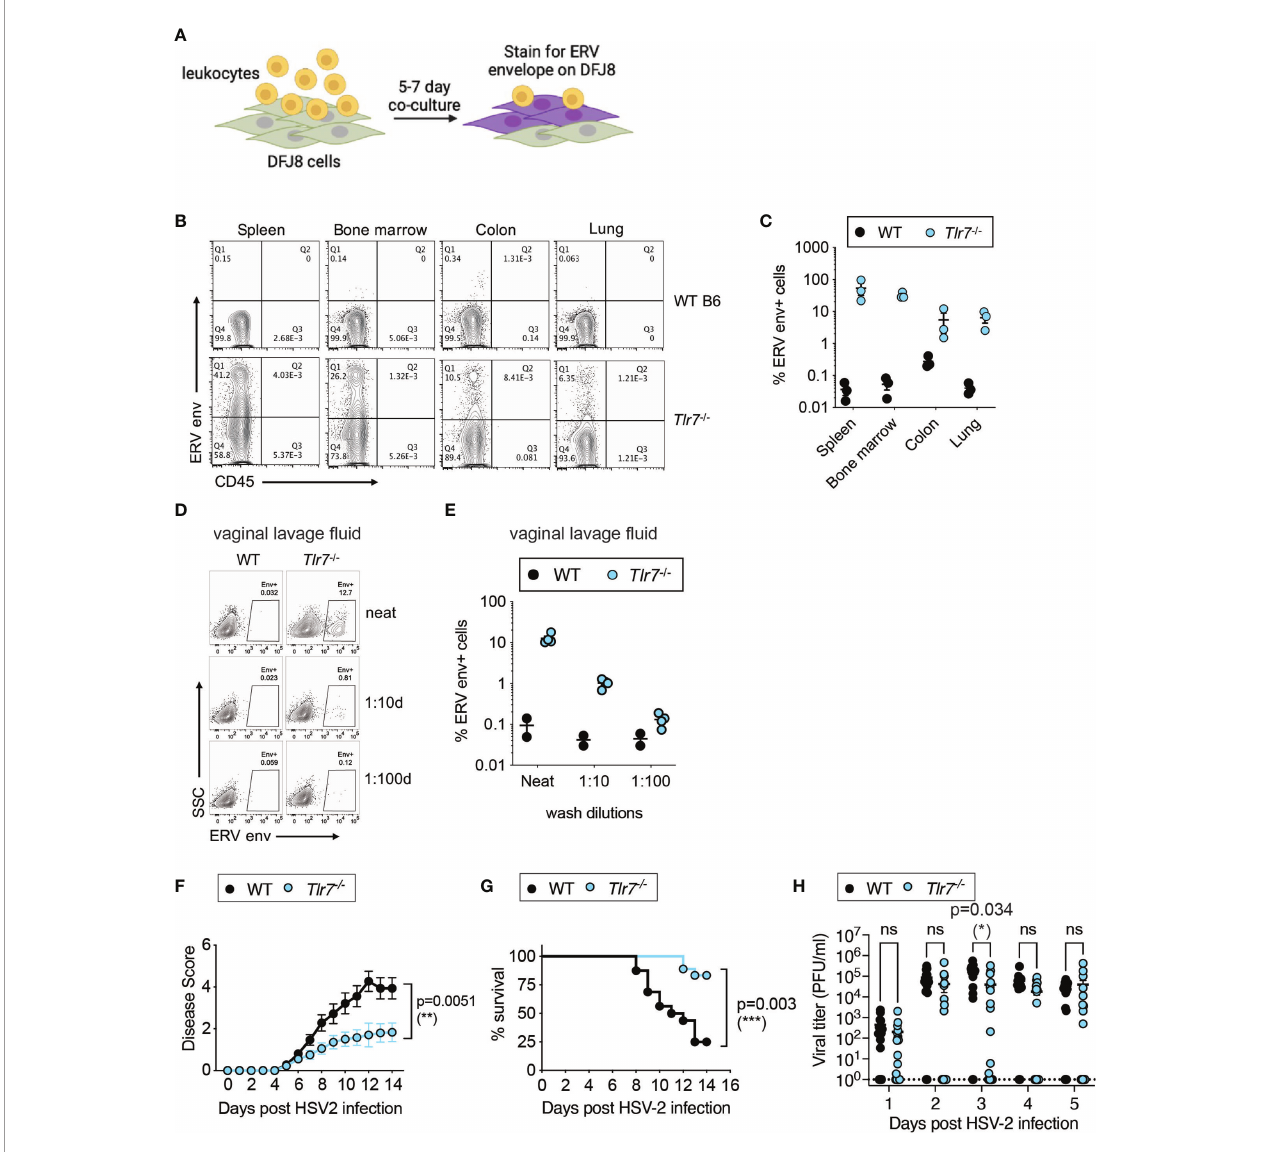
FIGURE 1 | Elevated infectious ERVs and HSV-2 resistance in Tlr7 -/- mice. (A) Schematic of DFJ8 co-culture assay to measure infectious ERVs. (B, C) Representative FACS plots of DFJ8 cells co-cultured with leukocytes from the indicated tissues for 7 days and stained with CD45 and ERV envelope, gated on live cells. Data from all mice were combined and plotted (n=3 per group). (D, E) DFJ8s cultured with dilutions of vaginal lavage fl uid from WT B6 (n=2) or Tlr7 -/- (n=4) and stained for ERV envelope protein. Representative data from more than three experiments. Mice were infected intravaginally with 2,500 PFU of HSV-2 and monitored for disease (F) and survival (G) , and vaginal viral titer (H) was quanti fi ed. The data are pooled from three independent experiments WT (n=16) and Tlr7 -/- (n=18). Statistical signi fi cance was calculated using two-way ANOVA for disease score, Mantle-Cox test for survival and two-way ANOVA Sidak ’ s multiple comparisons test for viral titers. *p < 0.05; **p < 0.01; ***p < 0.001. ns, not signi fi